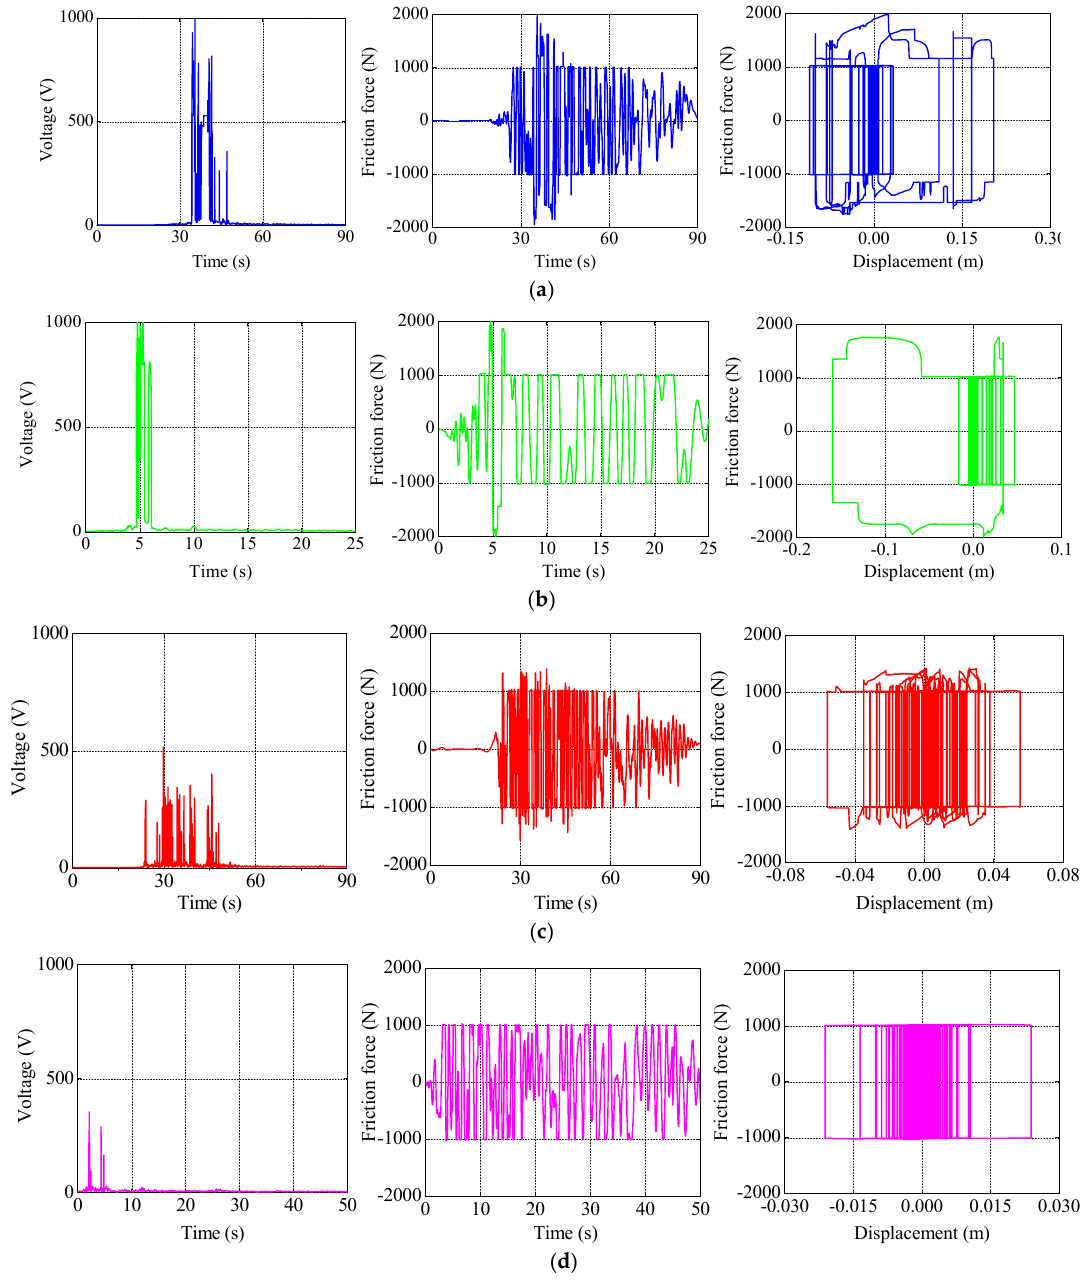
Figure 13. Time history of command voltage, damper force and force–displacement diagram of PFD under four earthquakes: ( a ) TCU068 ‐ NS record for Chi ‐ Chi earthquake; ( b ) WPI ‐ 316 record for Northridge earthquake; ( c ) TCU071 ‐ EW record for Chi ‐ Chi earthquake; and ( d ) No.095 ‐ S69E record for Taft earthquake.